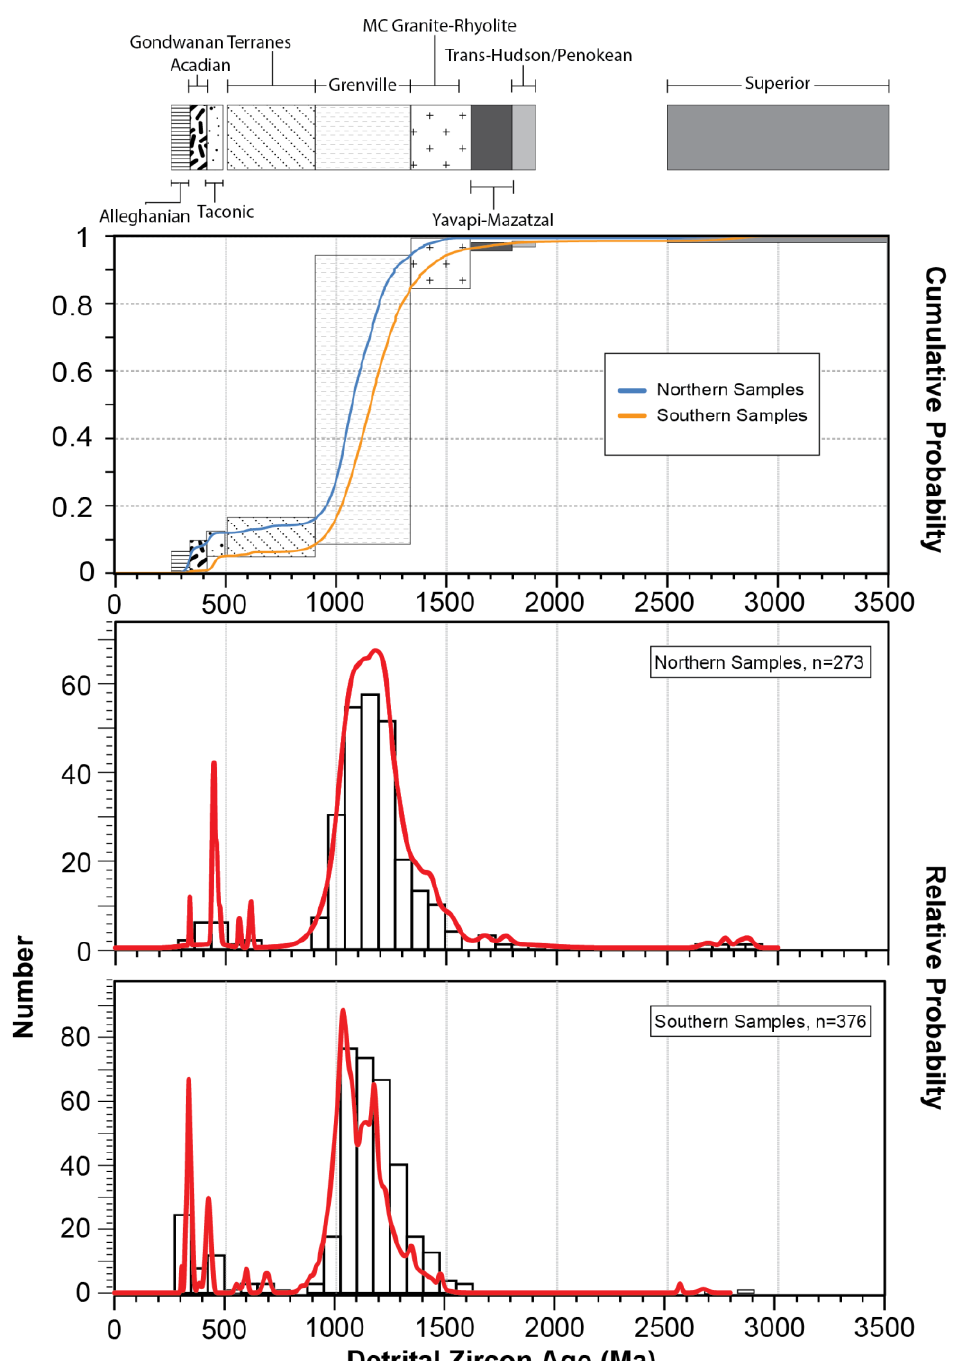
Figure 9. Stacked cumulative and normalized Age-probability density plots of the NS and SS.